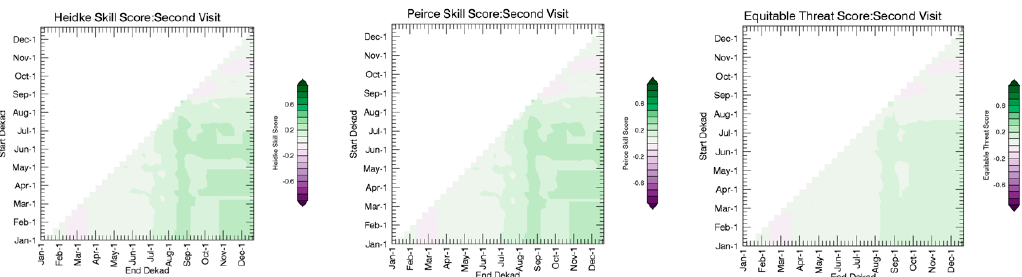
Figure 5. Heidke skill score, Peirce skill score, and equitable threat score for a variety of ARC2 rainfall accumulation intervals over the year. Higher skill scores reflect that the accumulation interval aligns better with farmer-identified payout years. The start and end dekads (on the y- and x-axis, respectively) indicate the 10-day period during the calendar that the accumulation calculation starts or ends. The lower-right portion of the graphic captures accumulation over the full calendar year, moving up from the lower right indicates a later start of accumulation, while moving to the left on the graphic represents an earlier end to the accumulation interval. Farmer-reported "bad years" on the second visit to 21 villages in Tigray, Ethiopia, served as the truth data.